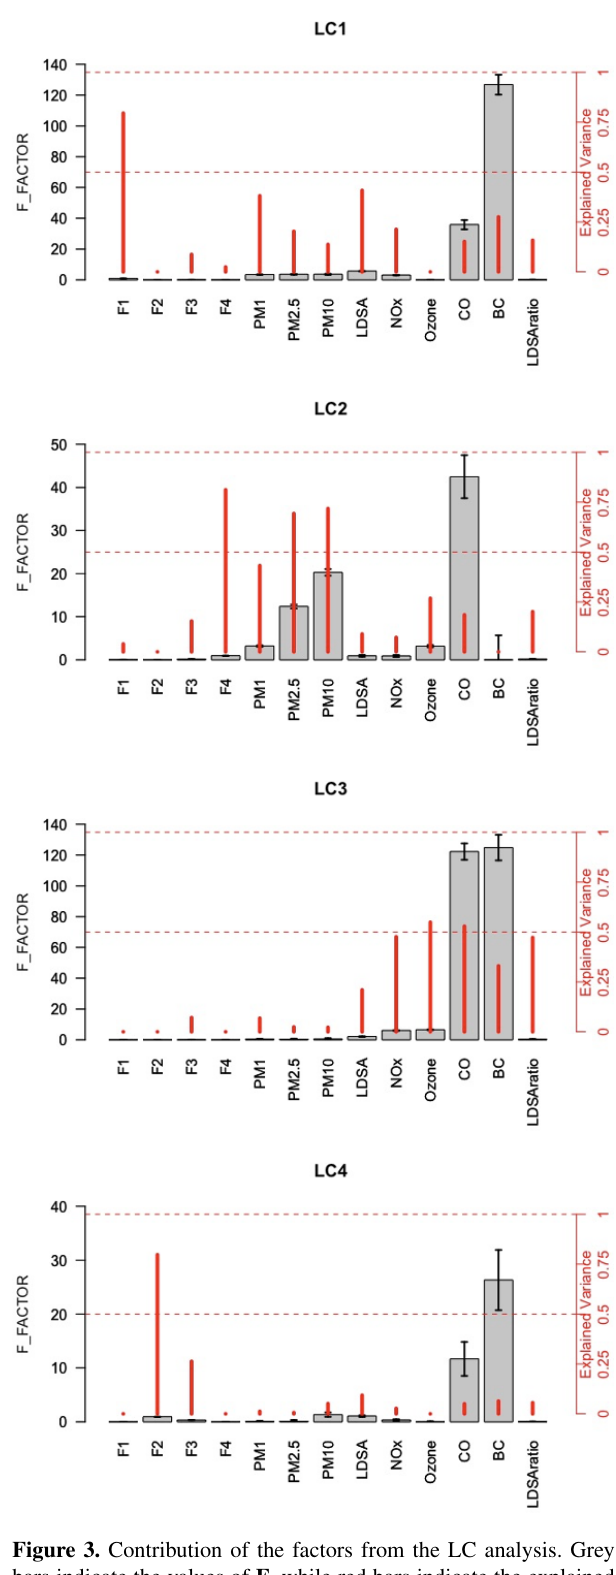
Figure 3. Contribution of the factors from the LC analysis. Grey bars indicate the values of F , while red bars indicate the explained variations for each